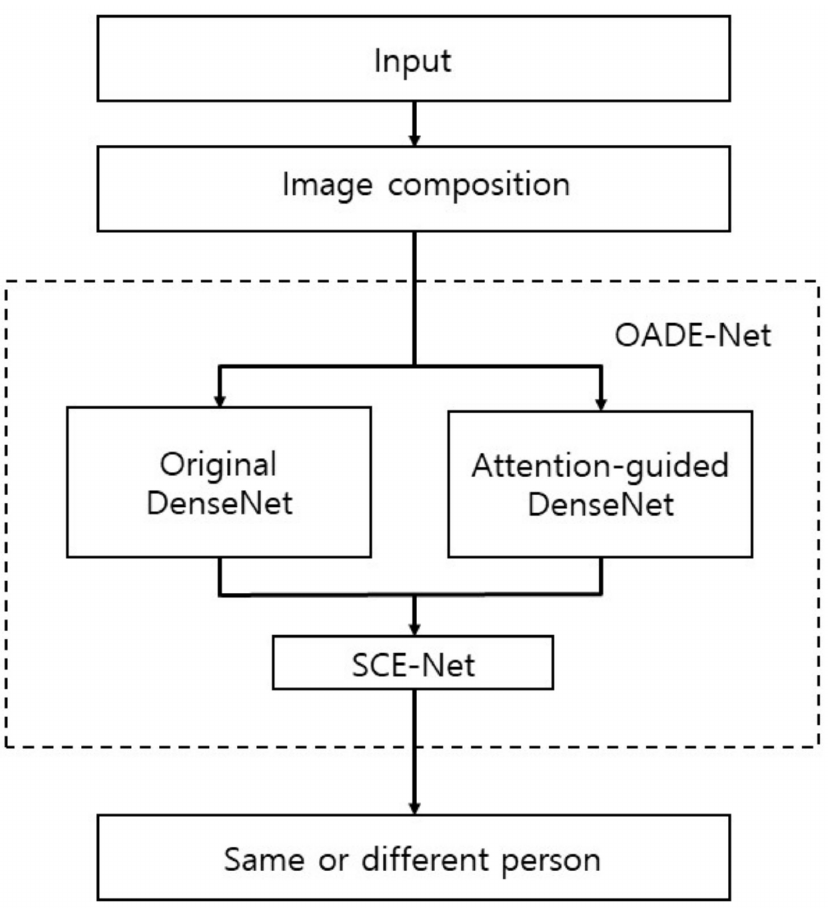
Figure 1. Overall procedure of proposed method. (OADE-Net: original and attention-guided DenseNet-based ensemble network; SCE-Net: shallow convolutional neural network for ensemble